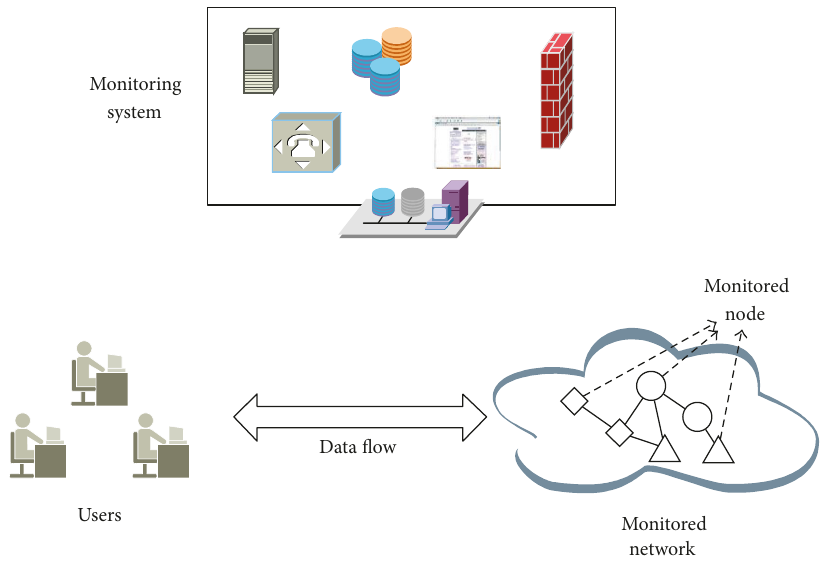
Figure 1: Cloud monitoring service